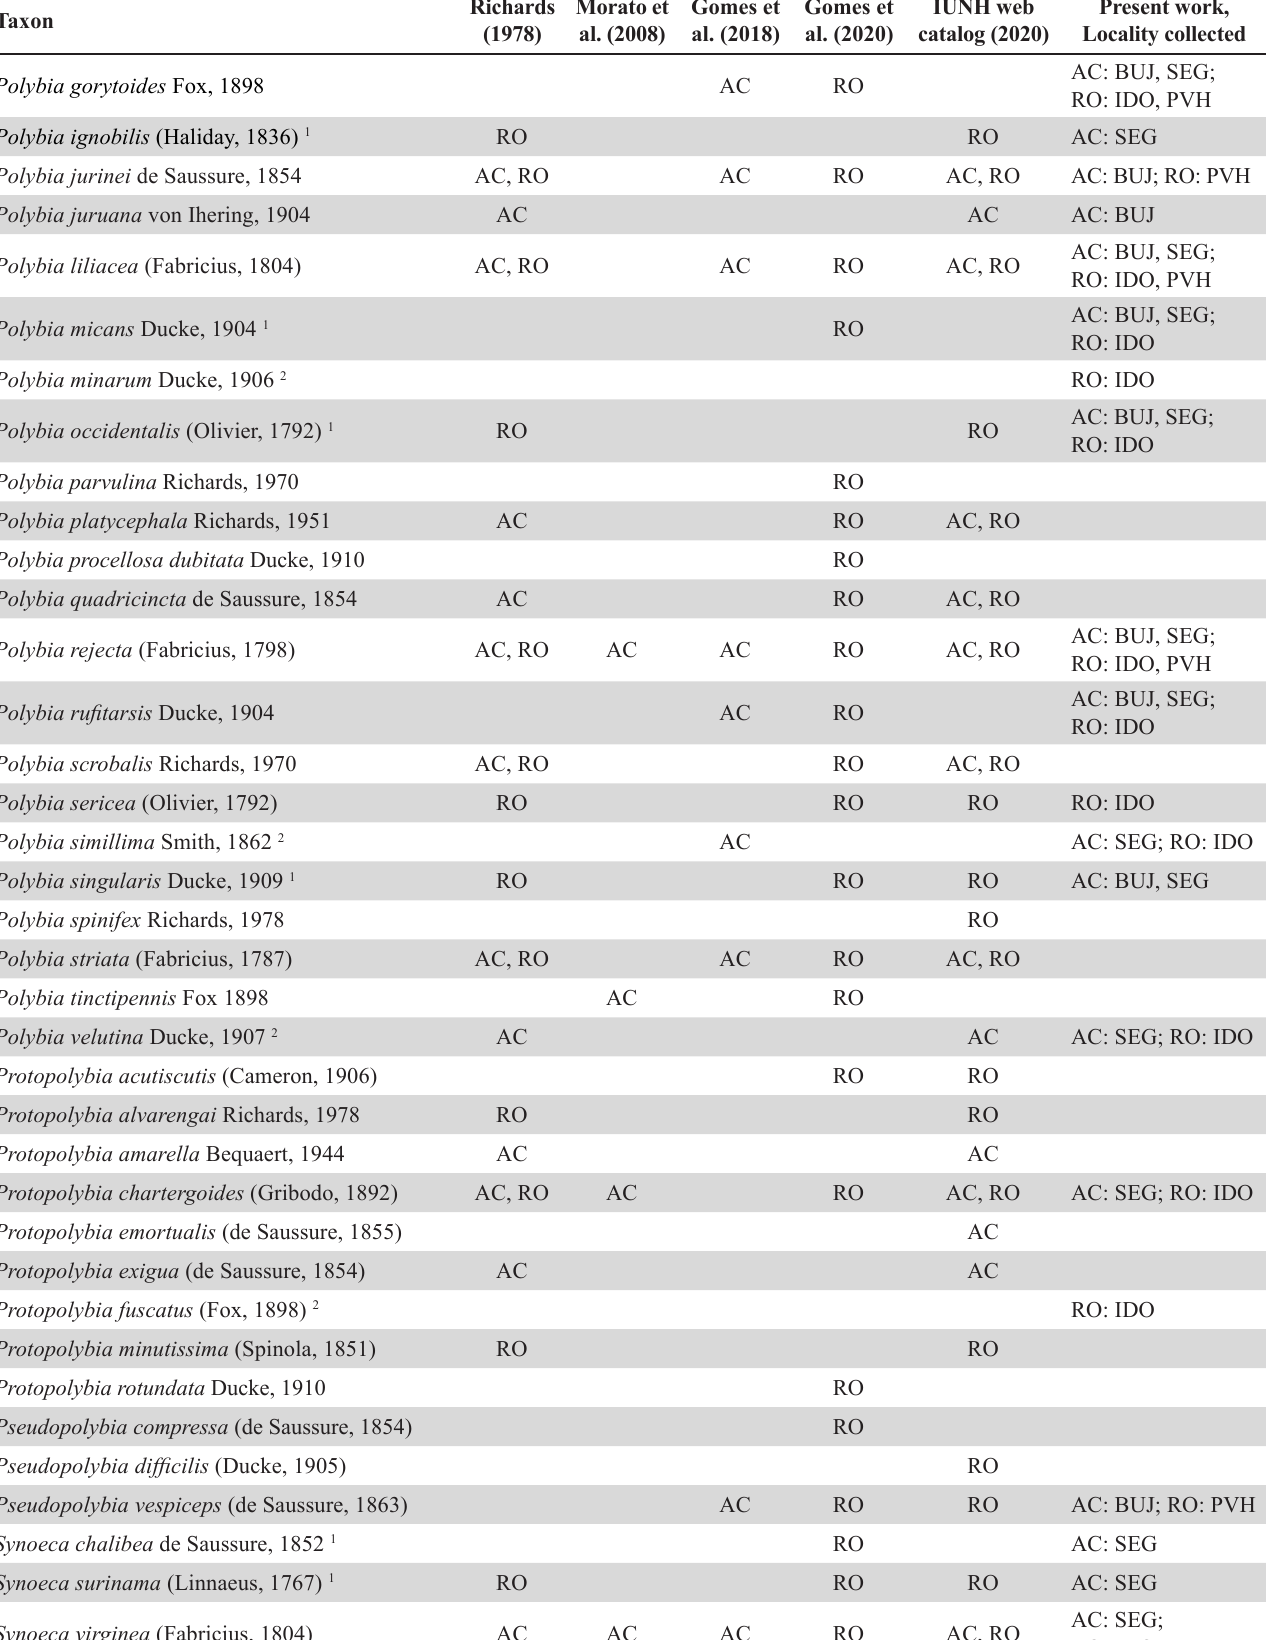
Table 1 . Species of social wasps from Acre and Rondônia states, listed by Richards (1978), Morato et al. (2008), Gomes et al. (2018), Gomes et al. (2020), web catalog from Natural History Laboratory of the Ibaraki University (IUNH 2020), and in the present work. 1 new distribution record for Acre; 2 new distribution records for Rondônia; * distribution records only in the descriptions of the species. AC=Acre; RO=Rondônia; BUJ=Bujari; SEG=Senador Guiomard; IDO=Itapuã do Oeste; PVH=Porto Velho.